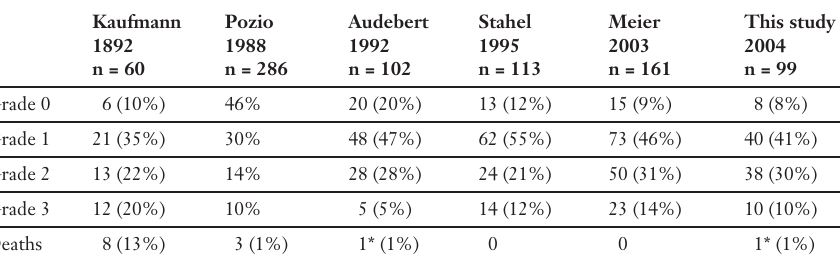
Comparative severity of snakebites in Switzerland (Kauf- mann [12], Stahel et al. [33], Meier et al. [18], our study), in Italy (Pozio [24]) and in France (Audebert